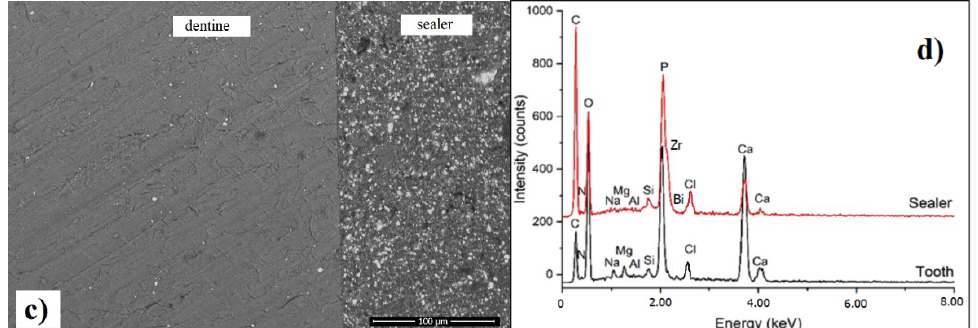
Figure 8. SEM images ( a , c ) of interfacial adaptation between sealer and root canal dentine (polished specimens) along with the corresponding EDX spectra ( b , d ): ( a ) neat sealer; ( c ) CNTs/CHX/AgNPs modified sealer. The transversal section was performed in the middle zone of the root.